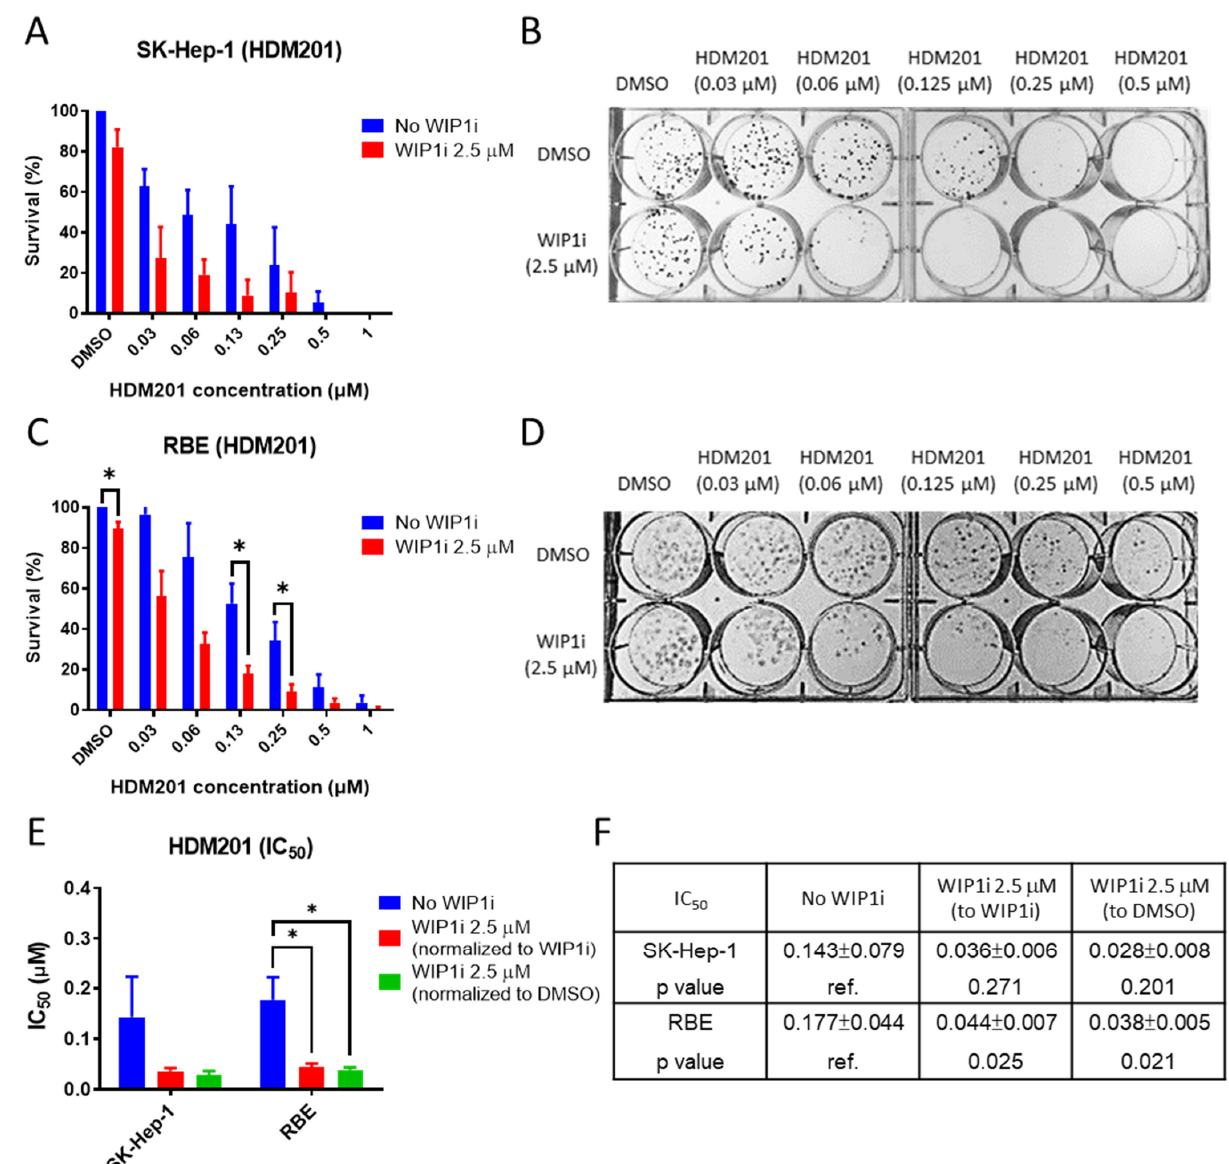
Figure 3. GSK2830371 enhanced colony formation inhibition by HDM201. SK-Hep-1 ( A , B ) and RBE ( C , D ) were treated with HDM201 alone or in combination with 2.5 µ M WIP1 inhibitor (WIP1i) for 72 h and percentage of survival was normalized to DMSO. ( E , F ) Summary of IC 50 ( µ M) of HDM201 alone or in combination with WIP1i and IC 50 was normalized to DMSO or WIP1i, respectively. *, p < 0.05. Panels A , C , E , and F show the mean ± SEM from three independent experiments performed in duplicate.